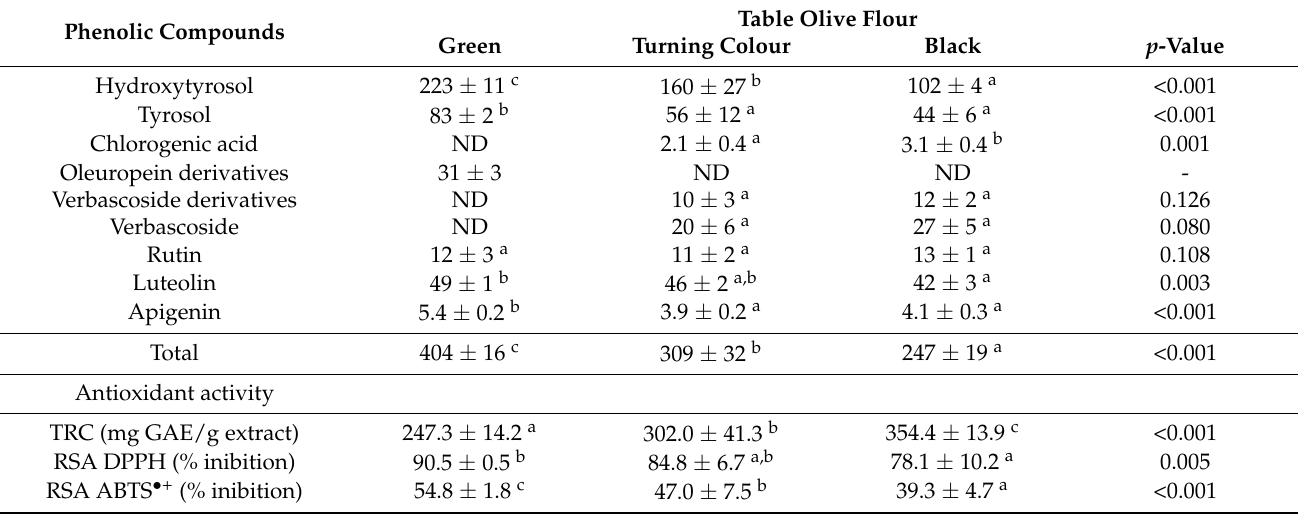
Table 3. Phenolic profile (mg/100 g dry matter), total reducing capacity (mg GAE/g extract) and radical scavenging activity of DPPH and ABTS of different table olive